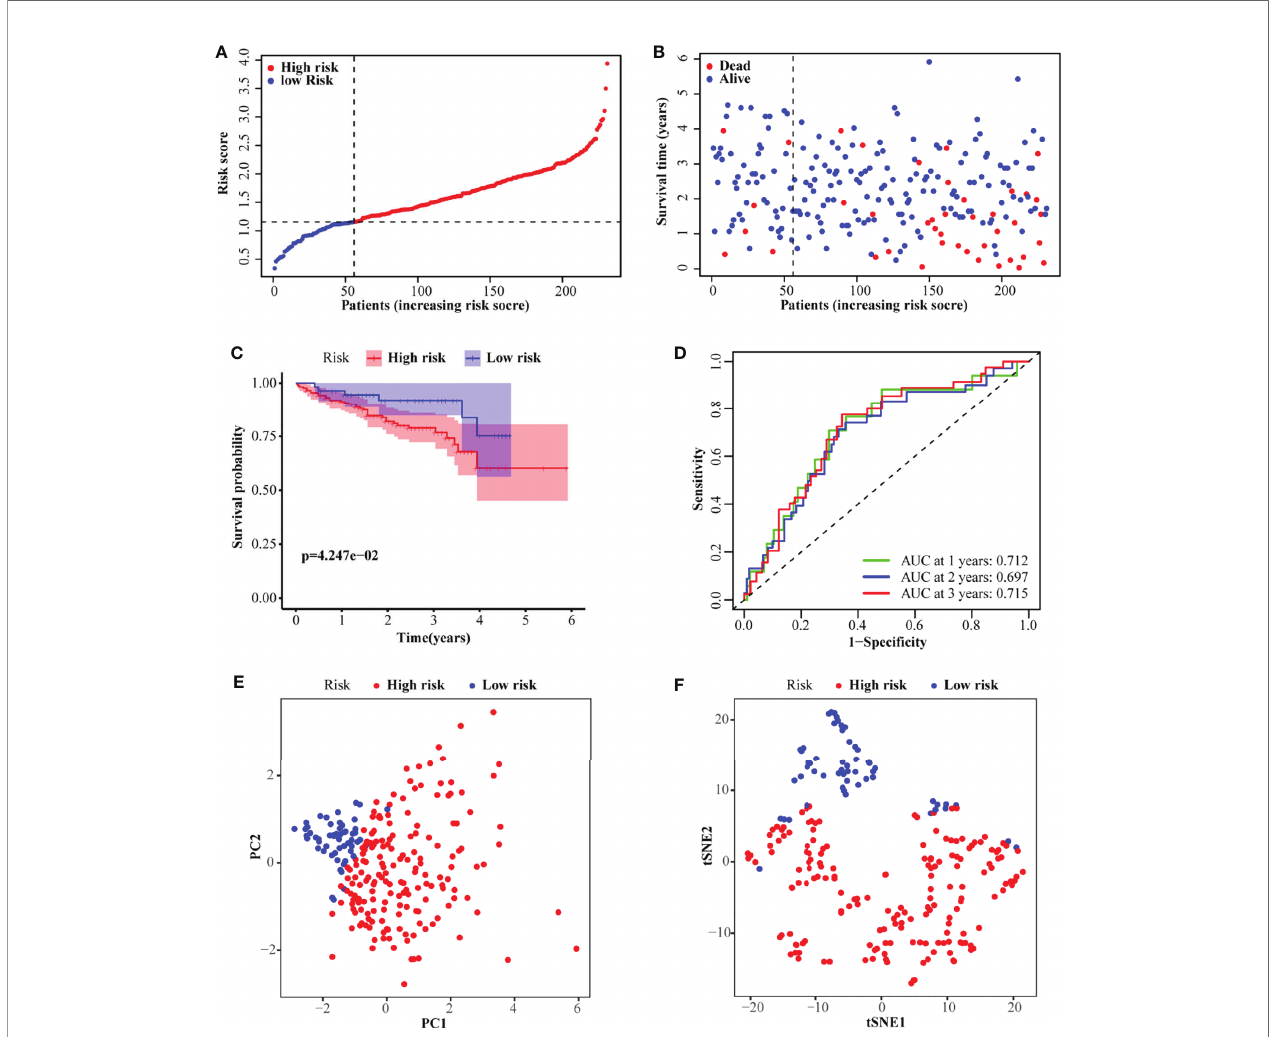
FIGURE 3 | Validation of the six-gene signature in the ICGC set. (A, B) The distribution and median value of the risk scores in the ICGC set. (C) Kaplan – Meier curves for the OS of patients in the high-risk group and low-risk group. (D) AUC of time-dependent ROC curves in the ICGC set. (E) PCA and (F) t-SNE analysis of the ICGC